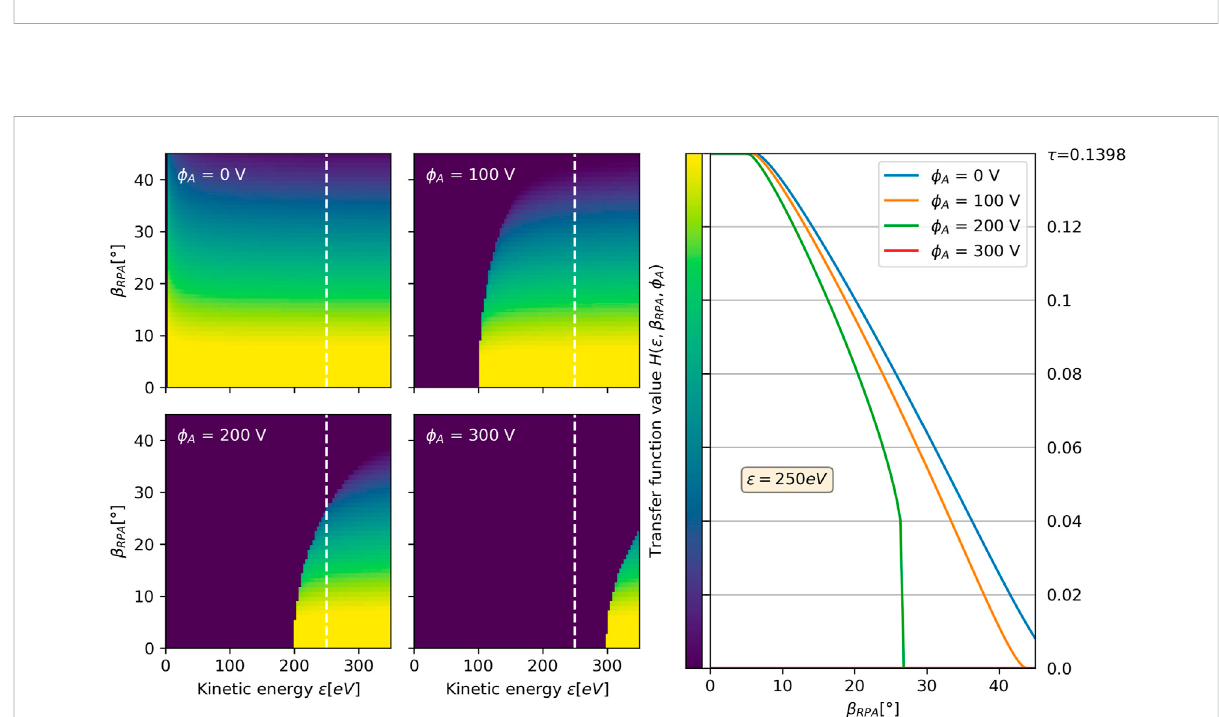
angle, such that f T ( v r , θ ) (cid:2) f sm ( v r ) · g ( θ ) . As the thruster is considered to emit ions homogeneously and with a symmetry axis along z (independent of ϕ ), spherical coordinates are well- suited. They allow for simplifying the numerical integration. study.